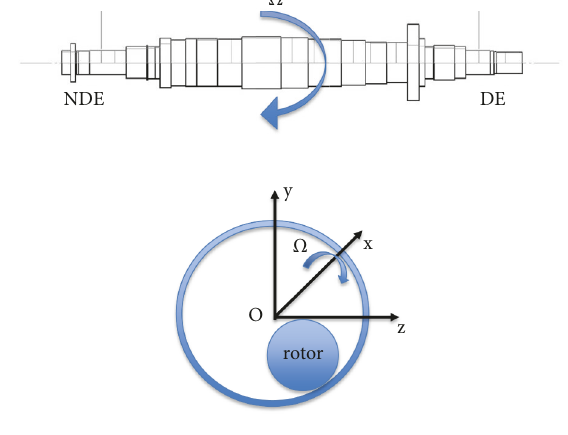
Figure 5: Scheme of the rotor